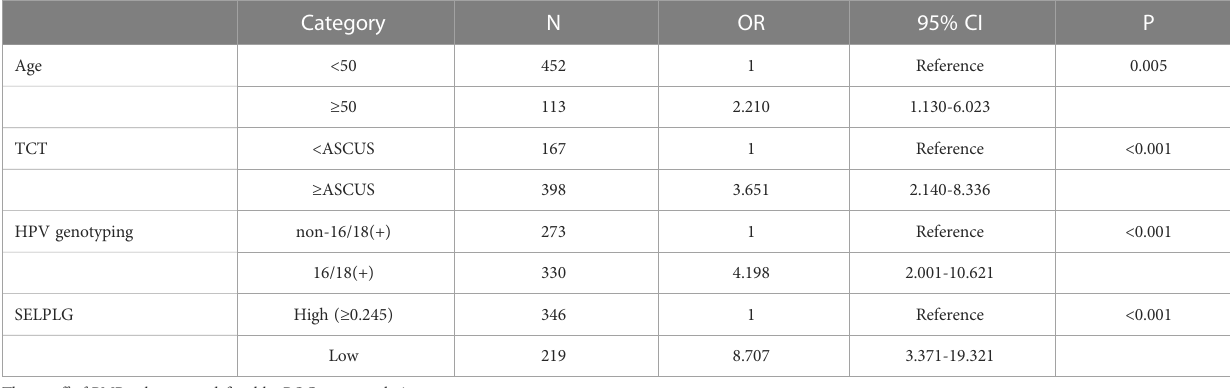
TABLE 2 Independent predictors for detection of CIN2+